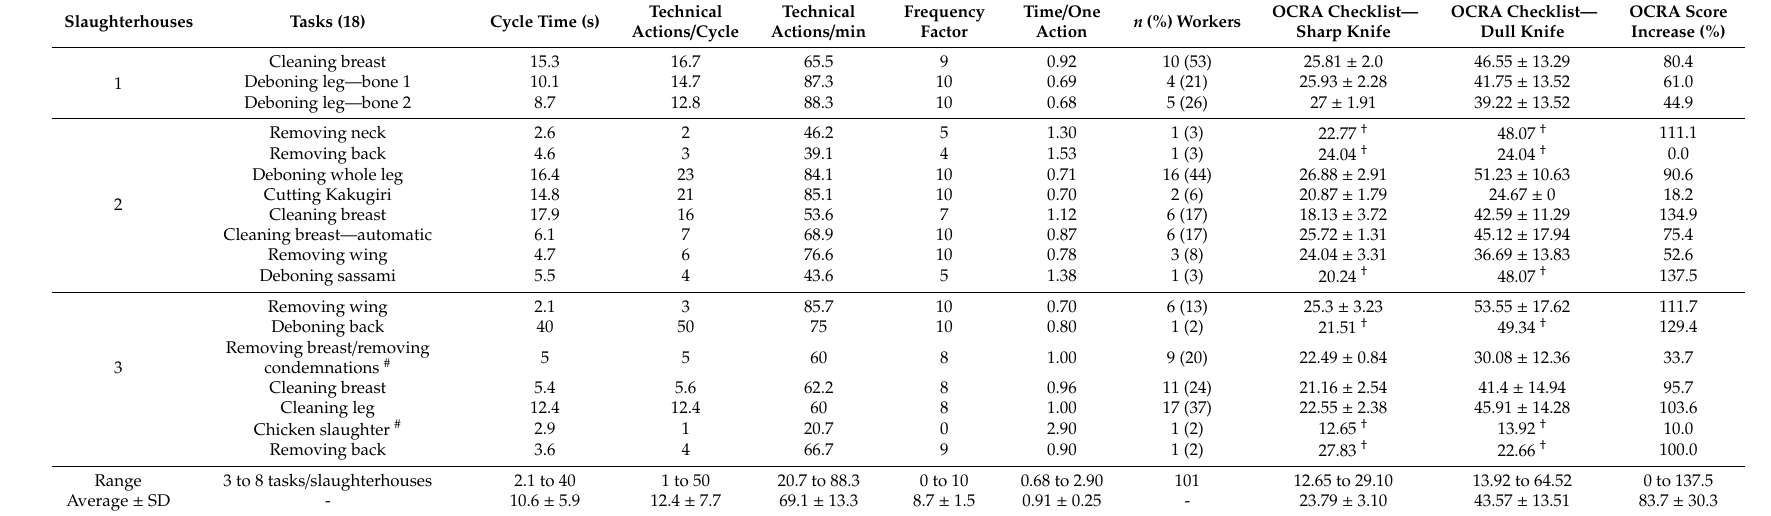
Table 4. Description of the cutting tasks for the body’s dominant